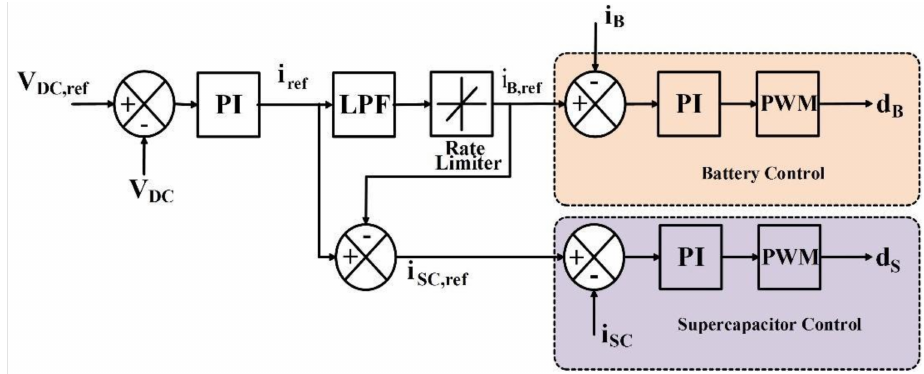
Figure 6. Description of the overall control mechanism for the current bifurcation between the SC and the battery unit for the PI control scheme.